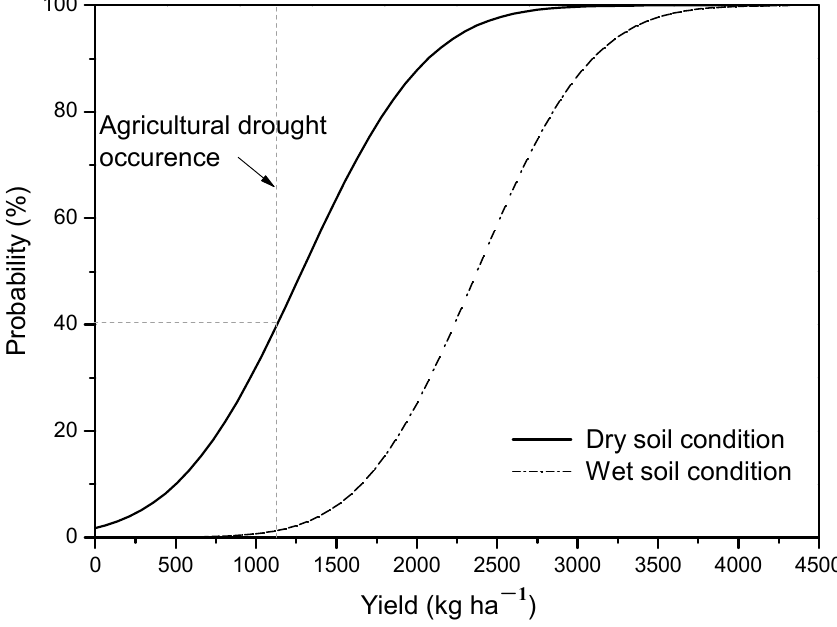
Figure 8. Probability of a minimum yield of spring wheat based on 1960–2011 precipitation from March to June. Soil conditions was classified into two groups by the amount of soil water content at planting of greater or less than 100 mm.